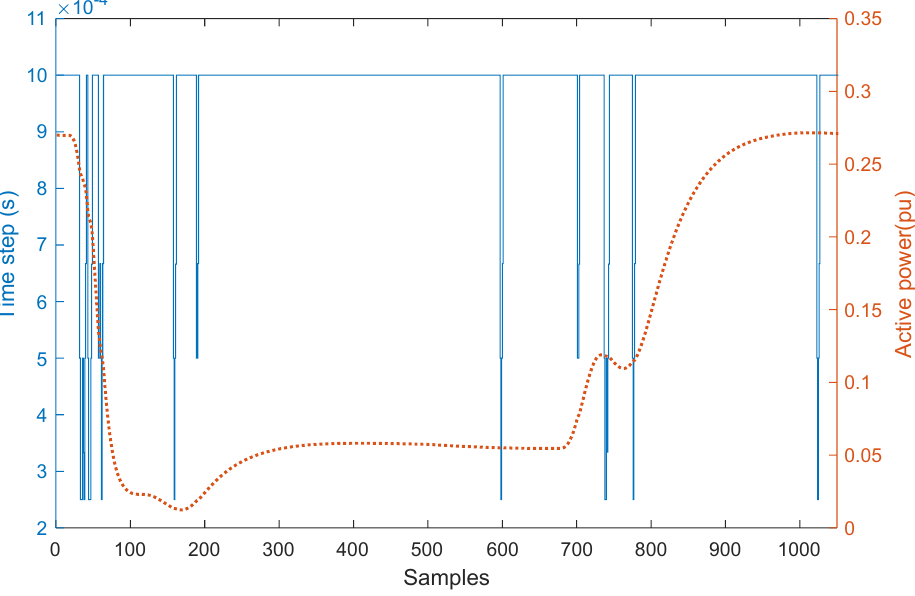
Figure 14. Simulation time steps during a fault in